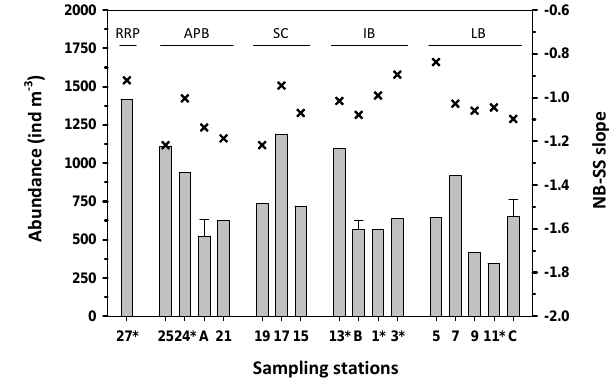
Fig. 6. Spatial distribution of mesozooplankton abundance (vertical bar) from the ZooScan counts and values of NB-SS slope (dark cross) along the BOUM transect. Mean values for stations A, B and C between day and night sampling. (*) night sampling. See text for details on the 5 regions.